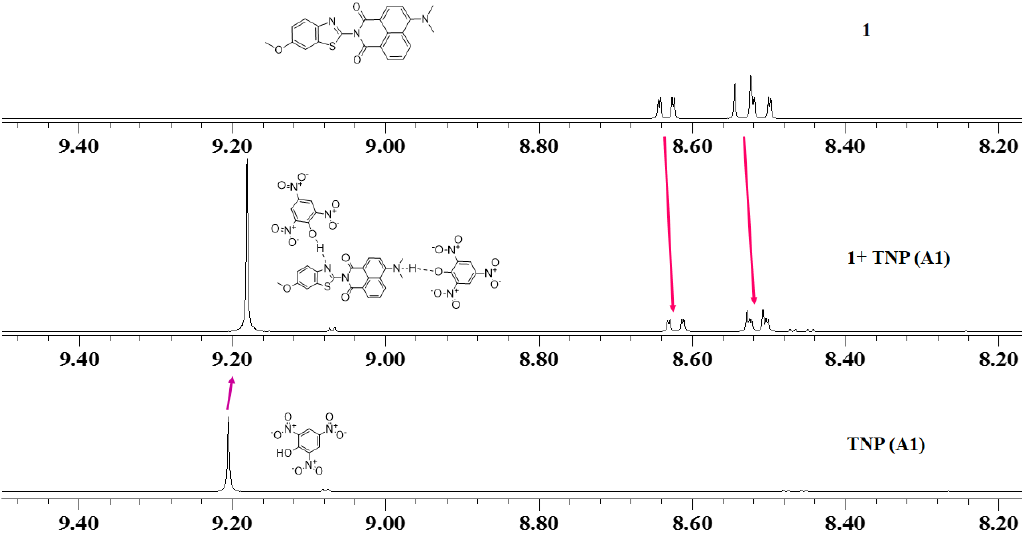
Figure 6. 1 H nuclear magnetic resonance (NMR) spectra of receptor 1, 2,4,6-trinitrophenol (TNP) and the complex formed between 1 and TNP ( A1 ).